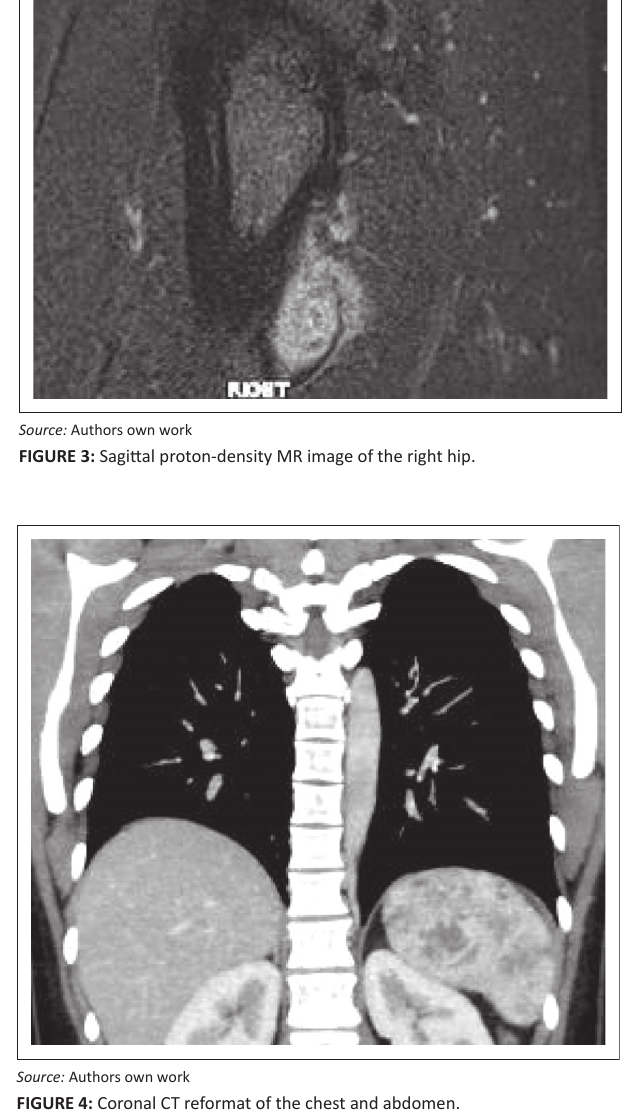
FIGURE 4: Coronal CT reformat of the chest and